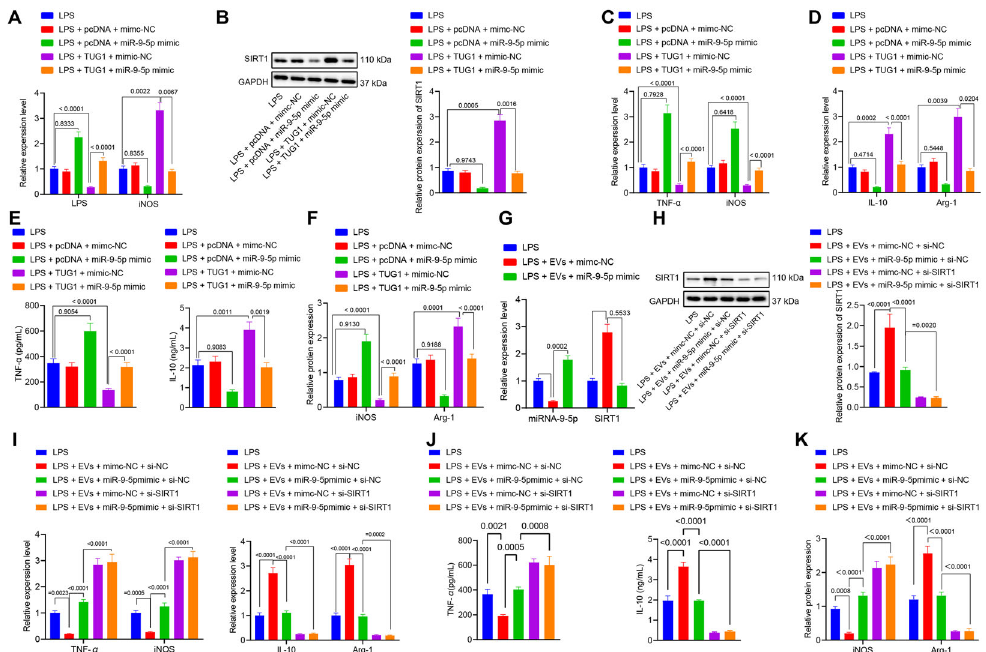
Fig. 5 EPC-derived EVs carrying TUG1 stimulates macrophages M2 polarization by upregulating SIRT1 expression through inhibition of miR-9-5p. A The expression of miR-9-5p and SIRT1 in macrophages transfected with pcDNA- TUG1 or miR-9-5p mimic or their NCs determined by RT-qPCR. B Western blot analysis for determination of protein expression of SIRT1 in macrophages transfected with pcDNA- TUG1 or miR-9- 5p mimic or their NCs. C RT-qPCR for measurement of mRNA expression of iNOS and TNF- α in macrophages transfected with pcDNA- TUG1 or miR-9-5p mimic or their NCs D RT-qPCR for measurement of the mRNA expression of IL-10 and Arg-1 in macrophages transfected with pcDNA- TUG1 or miR-9-5p mimic or their NCs. E IL-10 and TNF- α contents in the medium detected by ELISA. F The protein expression of iNOS and Arg-1 in macrophages transfected with pcDNA- TUG1 or miR-9-5p mimic or their NCs measured by western blot analysis. G RT-qPCR for determination of mRNA expressions of miR-9-5p and SIRT1 in macrophages cocultured with EPCs derived EVs measured by. H The protein expression of SIRT1 in macrophages cocultured with EPCs derived EVs examined by western blot analysis. I Determination of the mRNA expression of iNOS, TNF- α , IL-10, and Arg-1 in macrophages cocultured with EPCs derived EVs by RT-qPCR. J The levels of IL-10 and iNOS in the medium assessed by ELISA. K Measurement of the protein expression of iNOS and Arg-1 in macrophages cocultured with EPCs derived EVs by western blot analysis. Measurement data were expressed as mean ± standard deviation. One-way ANOVA was adopted for comparison